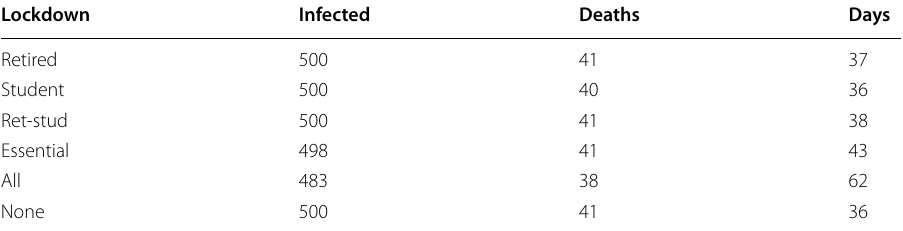
Table 2 Misinfodemic, no security measures, no detection Lockdown